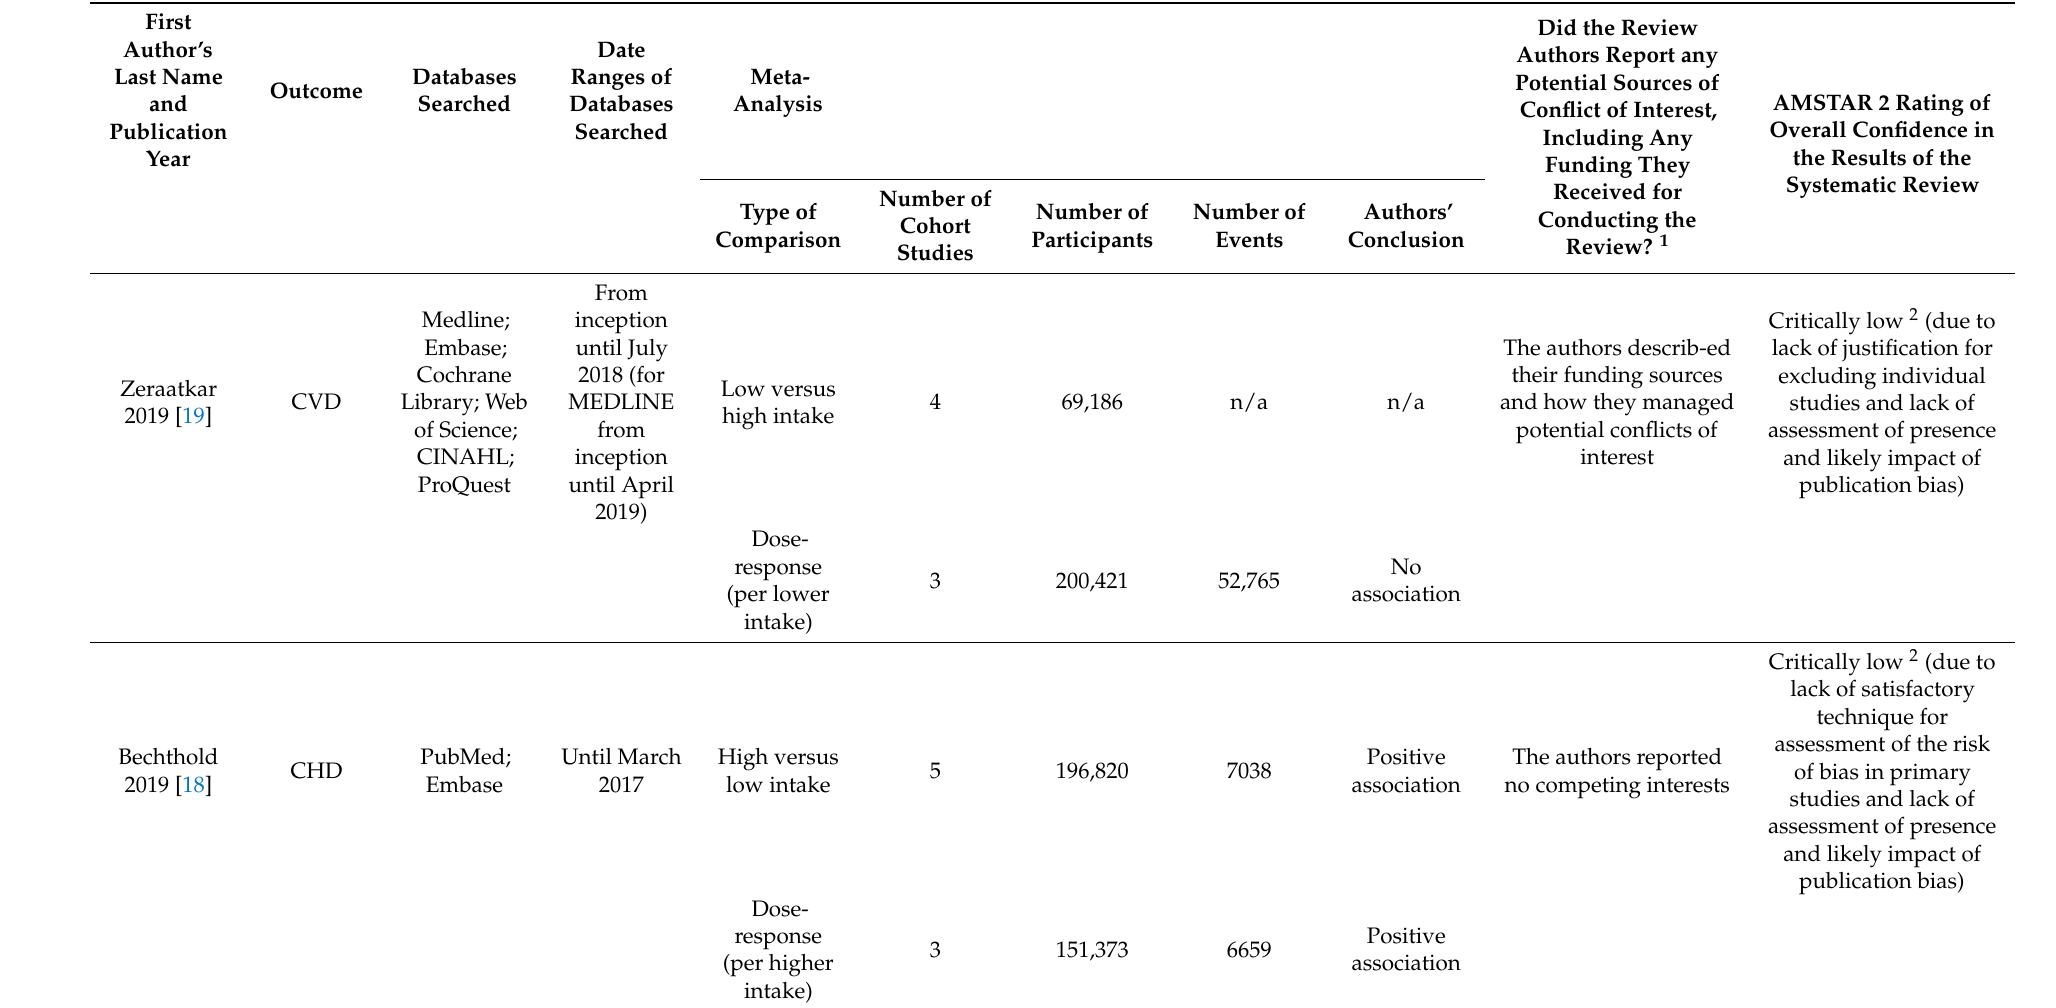
Table 3. Descriptive characteristics of systematic reviews on associations between processed meat and CVD, CHD, and